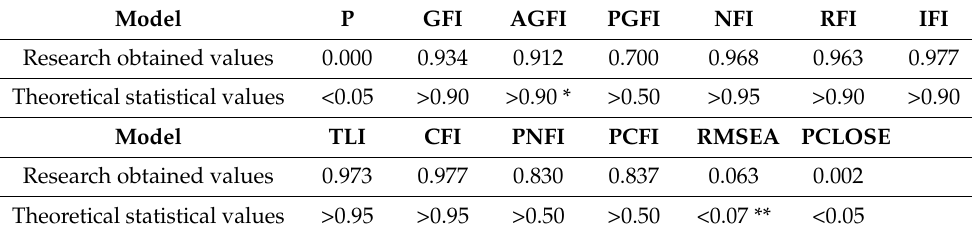
Table 3. Fit indices for the